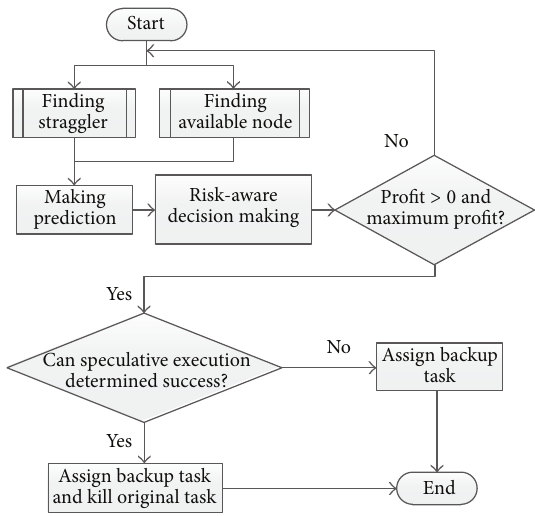
Figure 8: Flowchart of risk-aware